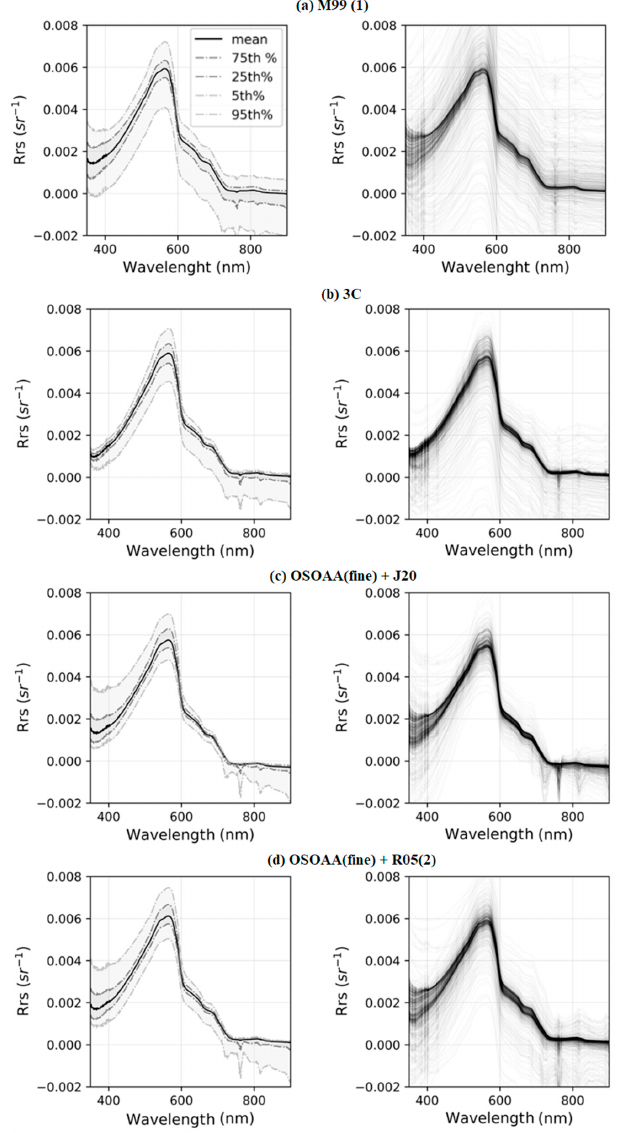
Figure 8. The first column shows spectra R rs percentile for the whole dataset, and the second column shows all R rs spectra obtained from data of the 7th day of measurement. shows all R rs spectra obtained from data of the 7th day of